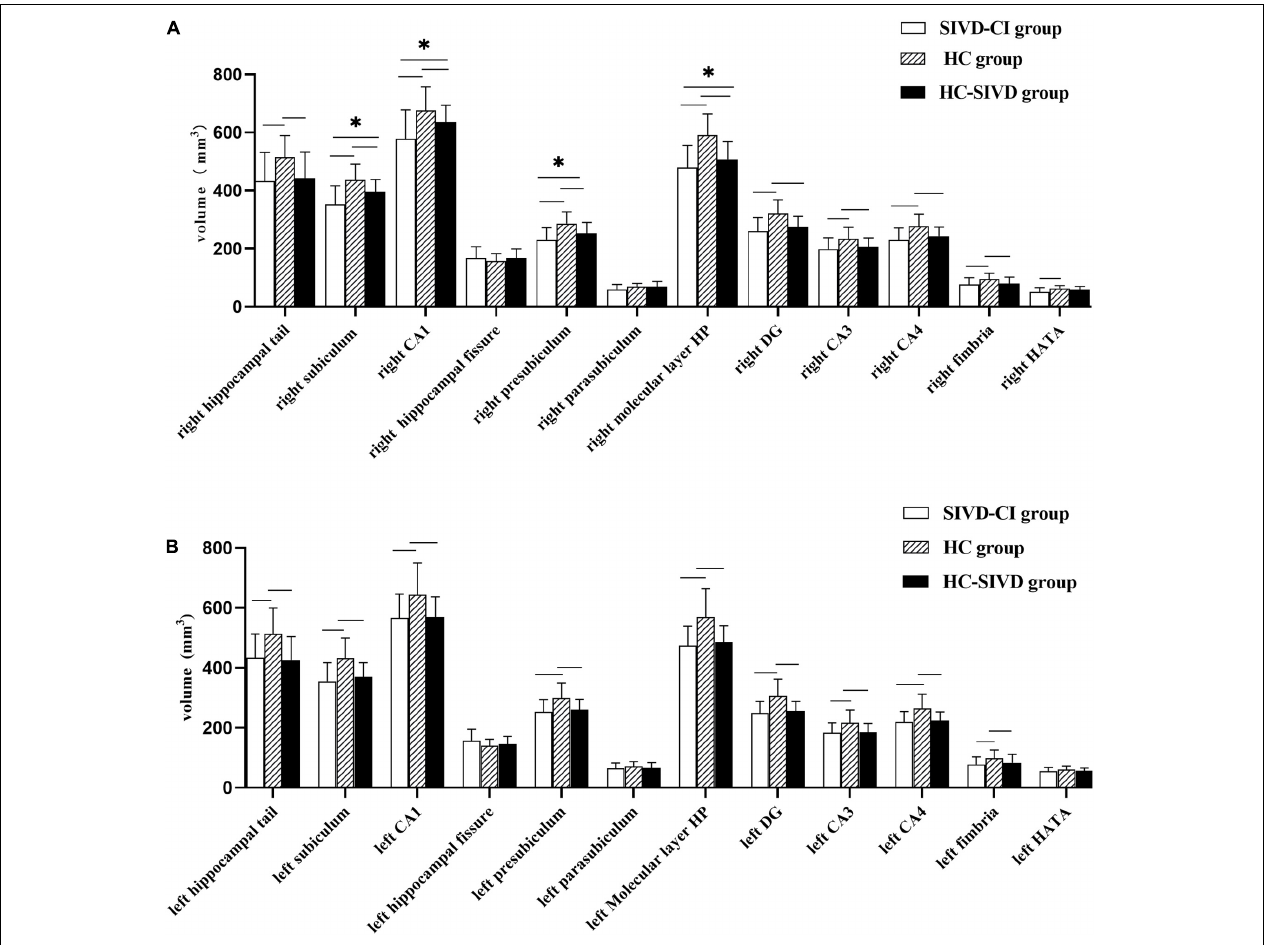
FIGURE 2 | Differences in subfield volumes of right (A) and left (B) hippocampus among the SIVD-CI, HC-SIVD and HC groups. SIVD-CI, SIVD patients with cognitive impairment; HC-SIVD, SIVD patients with normal cognition; HC, healthy control. CA, cornus ammonis; DG, dentate gyrus; HATA, hippocampal amygdalar transition area. − Significant difference between the SIVD-CI and HC groups, HC-SIVD and HC groups after FDR correction for multiple comparisons. ∗ Significant difference between the SIVD-CI and HC-SIVD groups after FDR correction for multiple